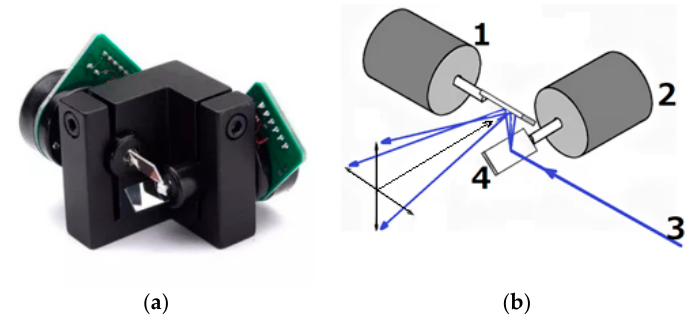
Figure 5. Galvanometer operating principle. ( a ) Photo of a galvanometer; ( b ) the principle of operation. 1 and 2 are motors, 3 is the laser beam, and 4 are mirrors for laser reflection.